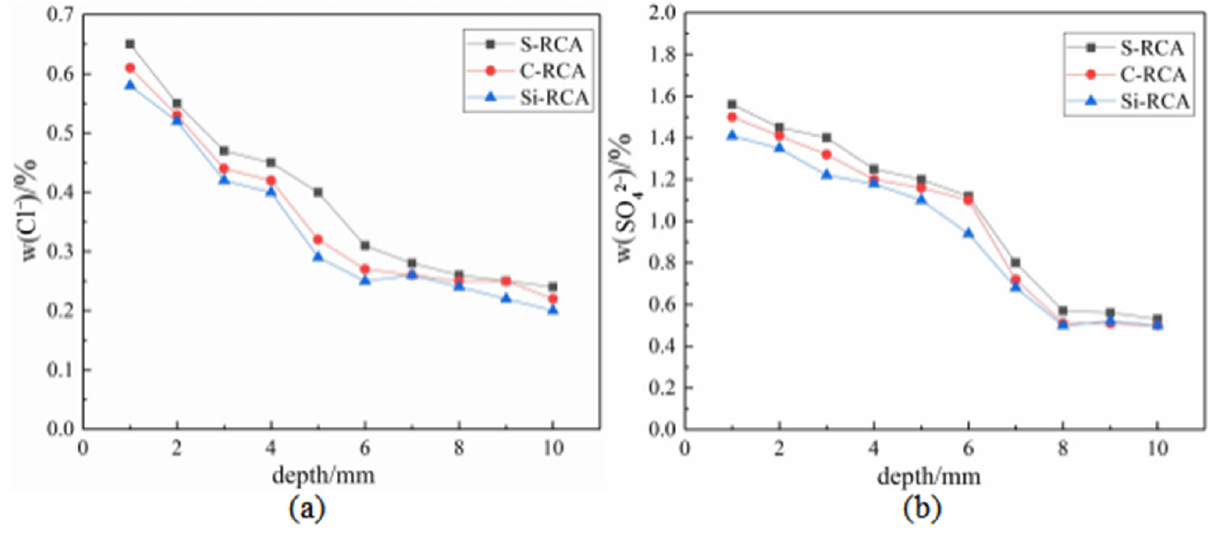
Figure 9. The content of aggressive ions: ( a )–the content of Cl − in RC, ( b )–the content of SO 42 − in RC.